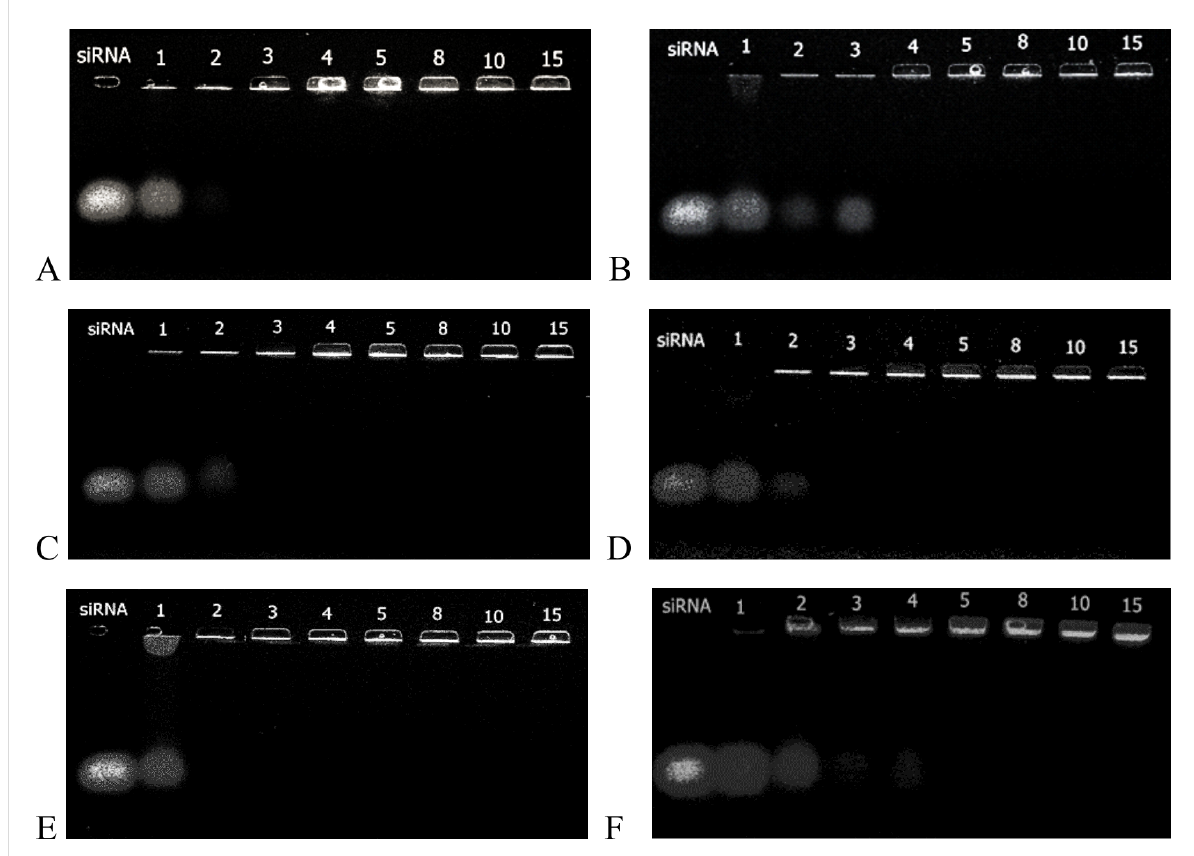
Figure 1: Agarose gel electrophoresis retardation assay of AAdPGs/siRNA polyplexes. (A) dPG-13Arg13His, (B) dPG-13Arg, (C) dPG-13His, (D) dPG-8Arg30His, (E) dPG-NH 2 50%, and (F) dPG-NH 2 90%. Naked siRNA always appears in the first lane. The numbers on the top of each lane correspond to the different N/P ratios.